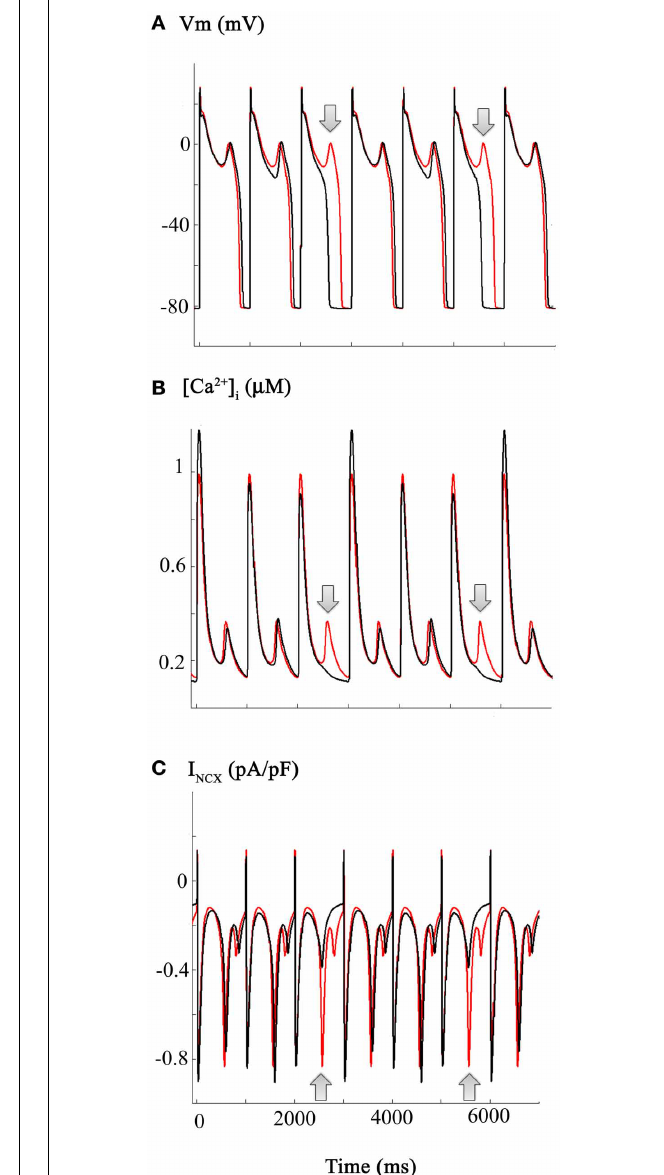
FIGURE 4 | Estimation and illustration of the effects of ranolazine on CO-induced changes in the action potential and underlying I Na − L , I Ca - L , and Na + /Ca 2 + exchange currents (I NCX ) in human ventricle. The effects of ranolazine (shown in black) were modeled as a selective 50% reduction in the I Na - L . Note that this reduces action potential, duration of every 3rd action potential, as well as decreasing the incidence and the frequency of EADs. However, these changes are complex. APD (Panel A ) as well as [Ca 2 + ] i and I NCX records all show variations or alternans, even at this fixed stimulus rate (1Hz). Panel (C) illustrates the corresponding ranolazine-induced changes in the I NCX . Note that in the action potential traces showing a ranolazine-induced shortening of APD, there is no spontaneous inward I NCX current (see also Figure 5 and Results). The arrows denote the “extra” EADs (Panel A ), and underlying [Ca 2 + ] i transient (Panel B ), and I NCX (Panel C )